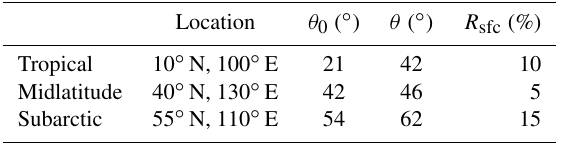
Table 5. Location of GFS profiles used to estimate the uncertainty associated with US standard profiles in the 6SV